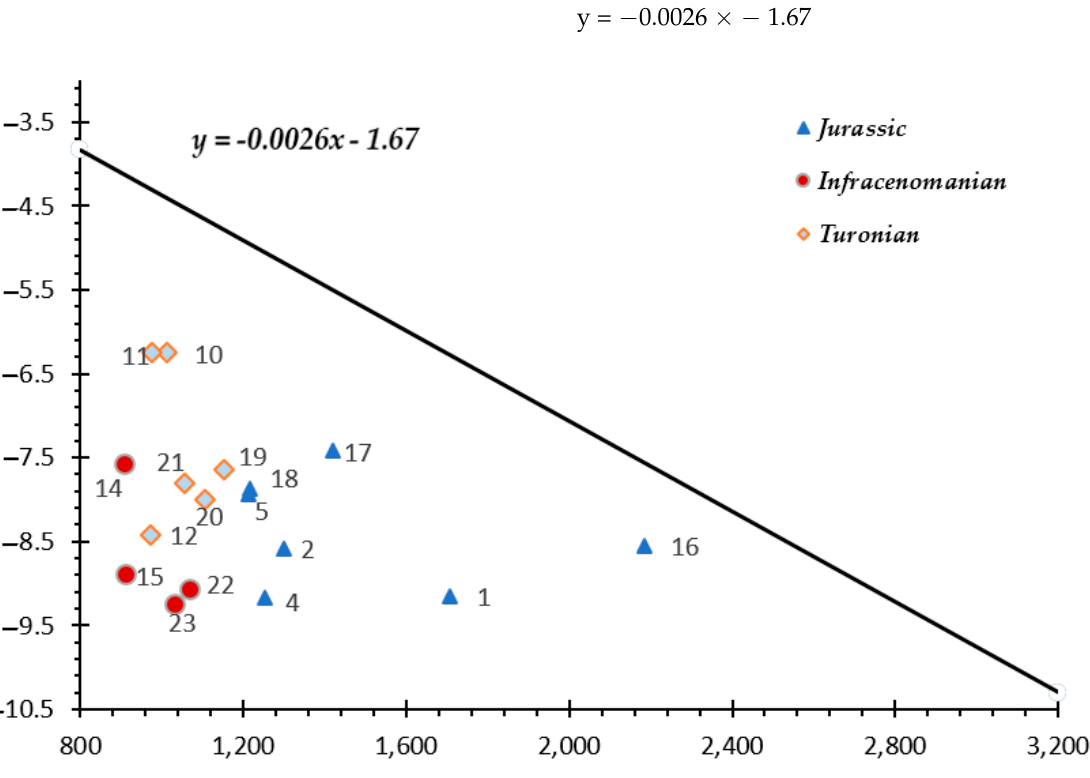
Figure 9. Plot of δ 18 O (‰) versus altitude.